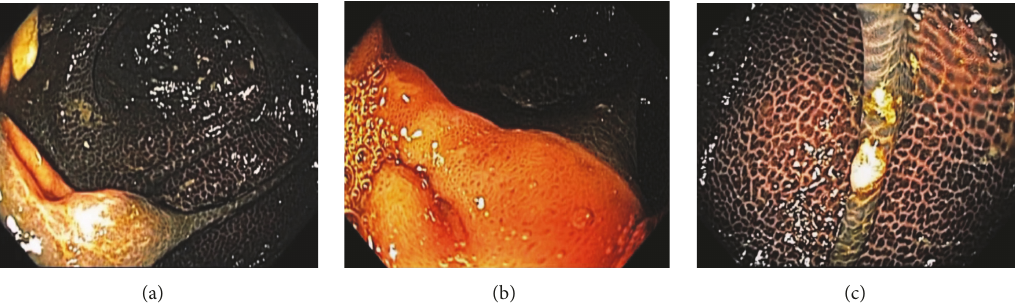
Figure 9: Endoscopic images of pseudomelanosis coli. The small bowel mucosa inside the terminal ileum and at the ileocecal opening is spared from pigmentation (a).Spotty pigmentationat theileocecal opening canbe observedwithin thetransitional zone (b). Colon adenomas usually lack pigmentation and are highlighted by pseudomelanosis